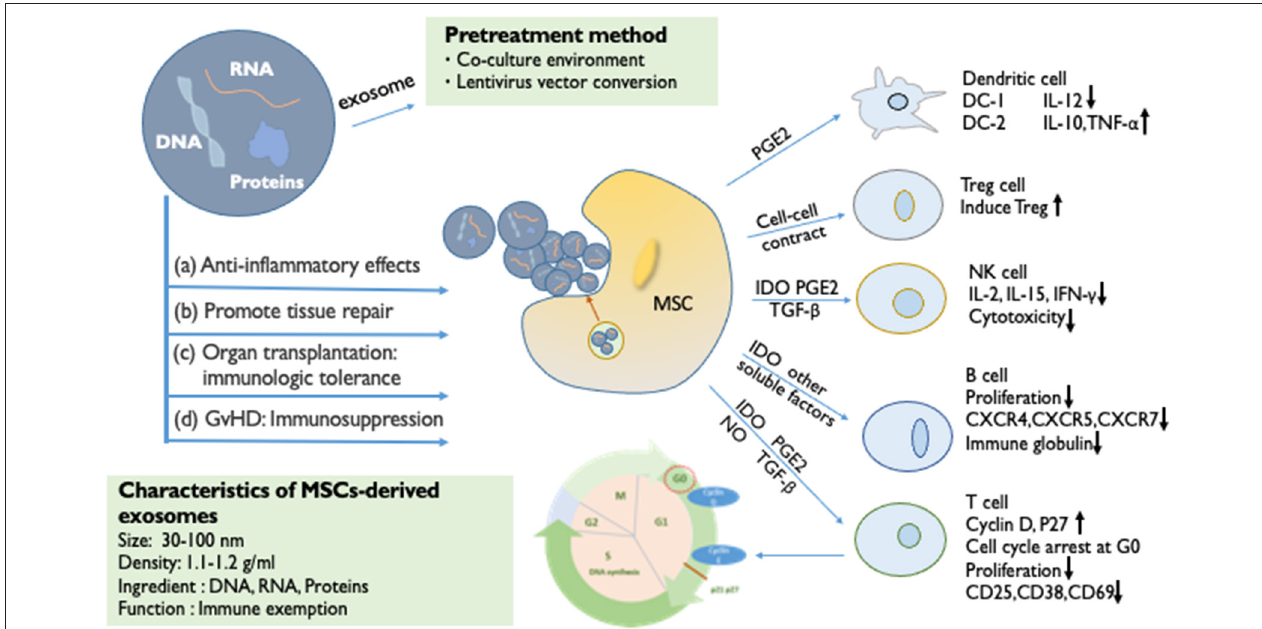
FIGURE 1 | The immunosuppressive effect of MSCs and MSC-derived exosomes. The immunomodulatory effects of MSCs can be largely attributed to paracrine factors (IDO, PGE2, NO, TGF- β , and exosome). By secreting soluble factors, the proliferation of T cells is inhibited (cell cycle arrest at G0), B cell activation is prevented (reduced proliferative capacity), NK cells are influenced (reduced cytotoxicity), and the differentiation and maturation of DC is affected. Through cell-to-cell contact, it can Tregs can be induced. MSC-derived exosomes are small vesicles of 30–100nm in diameter, which are rich in important biomolecules such as DNA, RNA, and proteins. MSC-derived exosomes have the same immunosuppressive effect as MSCs. (a) Anti-inflammatory effects. (b) Promotion of tissue repair. (c) Organ transplantation: immunologic tolerance. (d) Immunosuppression in GvHD. The targeted pretreatment of exosomes is an important means of current biological treatment. The method of changing the co-culture environment, and the lentiviral vector transferring functional proteins or mRNA into exosomes, can pre-enhance the activity of exosomes to enhance